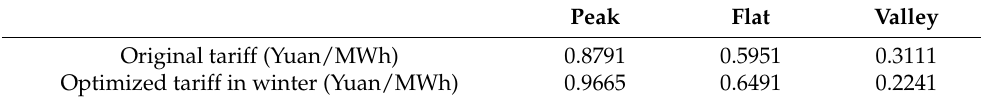
Table 7. The TOU tariff optimization results in winter.